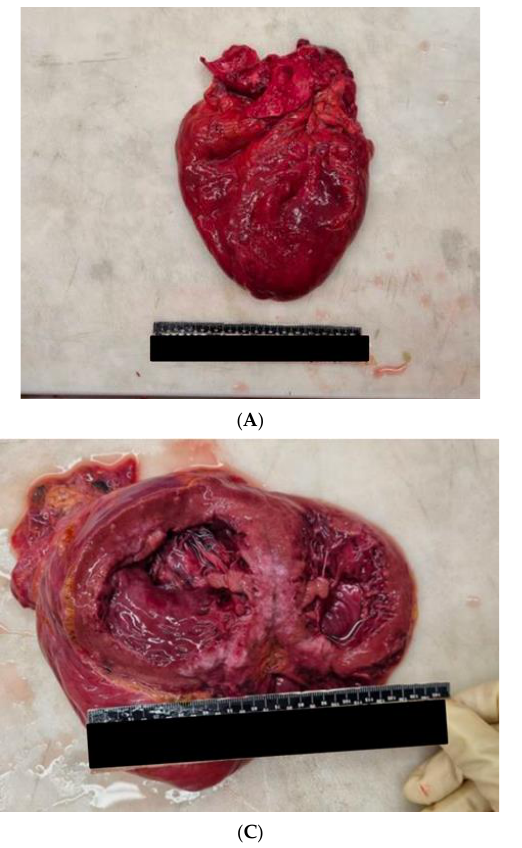
Figure 5. ( A – C ) Autoptic features of the heart: note the presence of increased myocardial thicknesses at the left sections consistent with concentric hypertrophy and also diffusely sclerotic valves. (A-B) view from top; (C) coronal section.